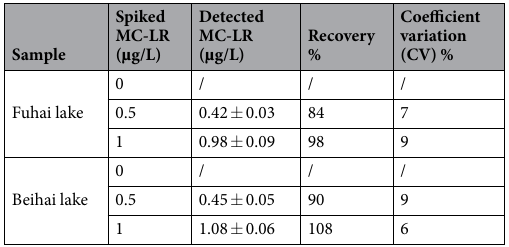
Table 1. Recovery of MC-LR in real lake samples using the immunosensor (n = 3). “/”means not